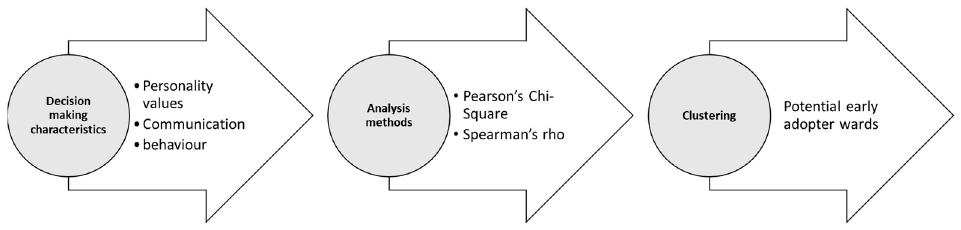
Figure 10. Overview of Ward’s method for EV clustering proposed in [3].